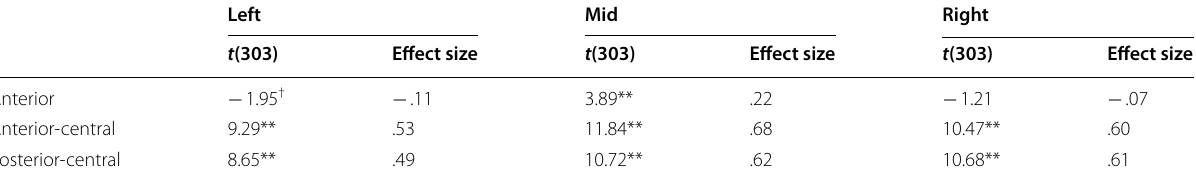
Table 6 Simple effects of correctness on ERN amplitude, as a function of electrode